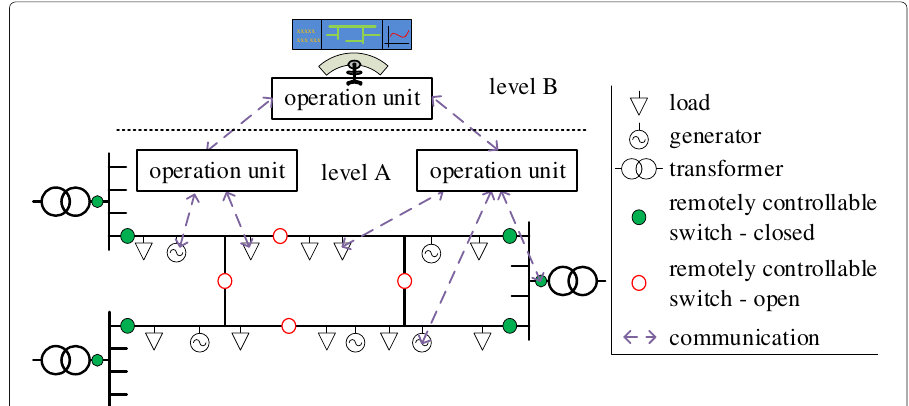
Fig. 4 Hierarchical operation architecture for a distribution grid with two layers: lower level A and supervisory level B. Source: Adapted from Drayer